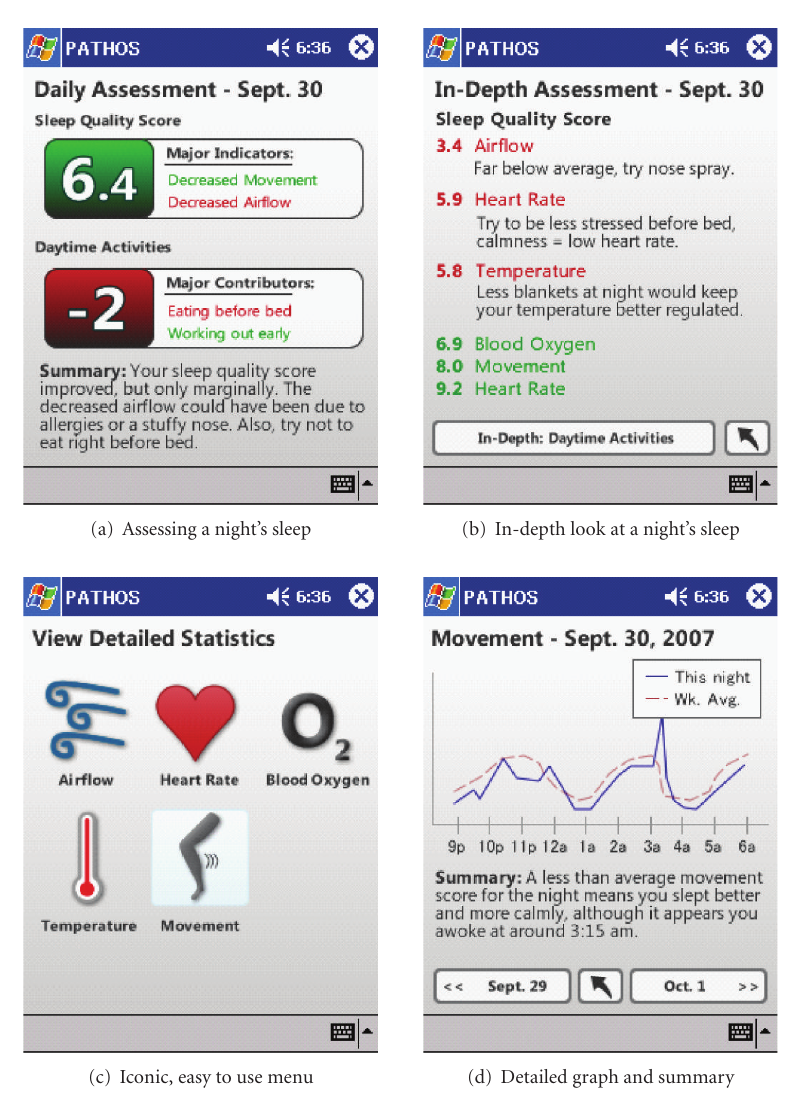
Figure 3: Some screenshots of our